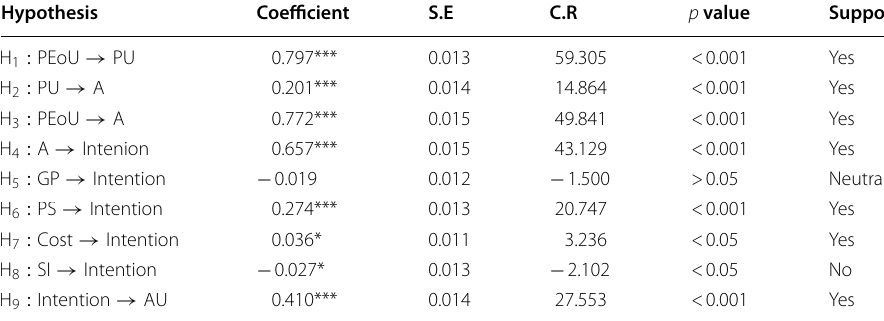
Table 6 Summary of the hypothesis test